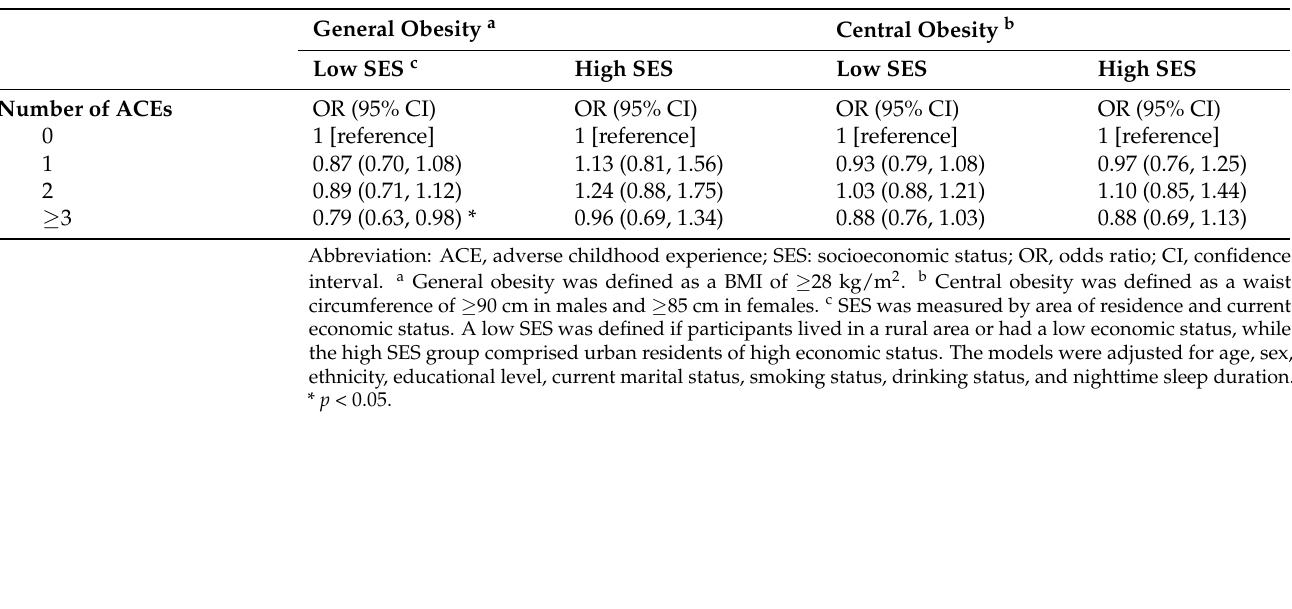
Table 3. Associations of the number of ACEs with general and central obesity in different SES